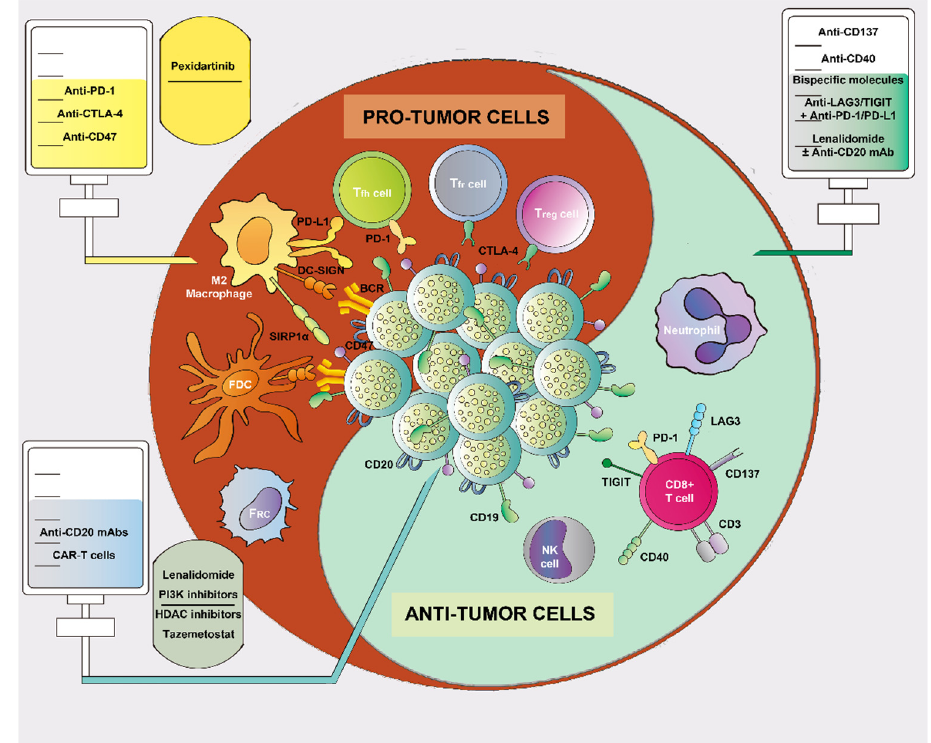
Figure 1. A roadmap of various drugs directed against follicular lymphoma (FL). Therapies against FL cells include anti-CD20 monoclonal antibodies (mAbs), CAR-T-cells, immunomodulatory drugs, PI3K inhibitors, Bruton’s tyrosine-kinase inhibitors, and epigenetic regulators, which can also in- fluence the surrounding microenvironment. Regarding the TME, therapies against cells with pro- tumor activity include immune checkpoint inhibitors, anti-CSF-1, and anti-CD47. These drugs aim to block different targets expressed in T-cells (Treg, Tfh, and Tfr) and macrophages, thus stimulating the immune response. Therapies directed toward TME cells with anti-tumor activ- ity include anti-CD137 and anti-CD40 mAbs (immune checkpoint activators), bispecific molecules, anti-LAG3/TIGIT + anti-PD-1/PD-L1 therapy, and